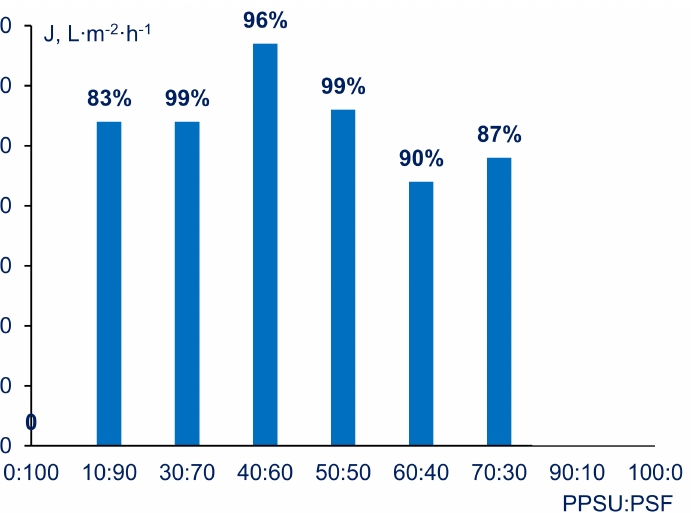
Figure 9. Human serum albumin (HSA) solution flux (J) and HSA rejection of membranes vs. PPSU:PSF blend ratio in casting solution (series